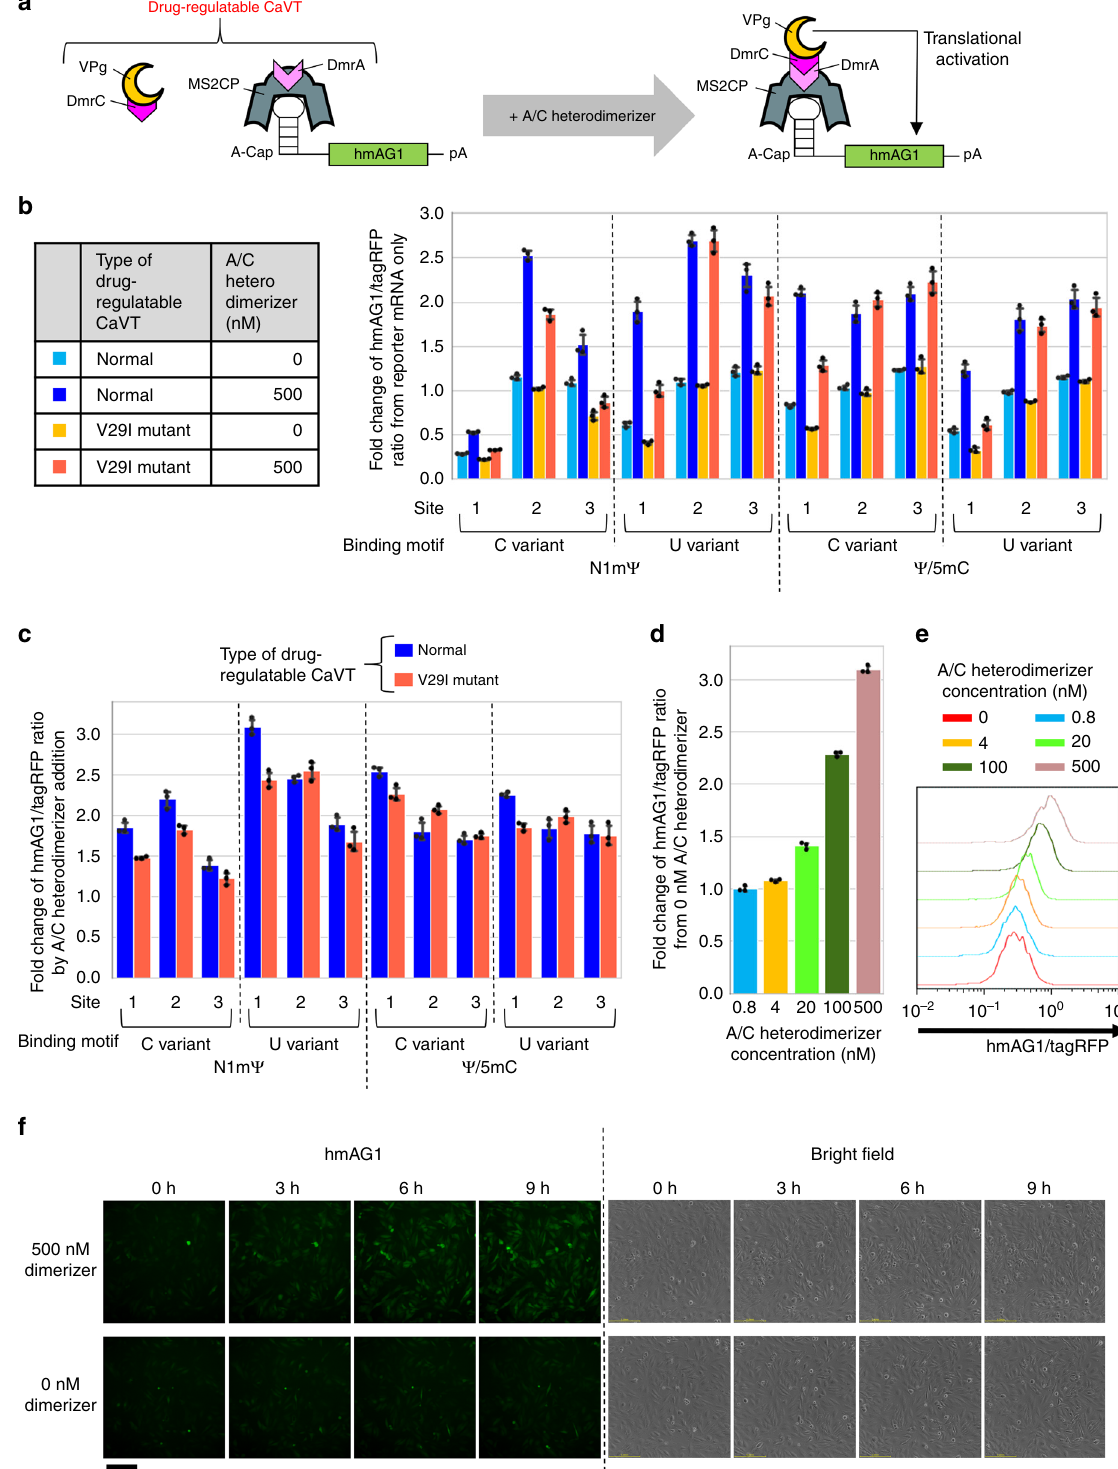
(Thermo Fisher Scienti fi c). One day after that, the cells were harvested using 200 μ L/ well of Trypsin/EDTA and suspended in 500 μ L/well of DMEM. Then, the fl uores- cence was measured by a BD Accuri C6 with CFlow Plus software (BD Biosciences, San Jose, USA). The excitation wavelength was 488nm for both tagRFP and hmAG1. Bandpass fi lters were 585/40nm for tagRFP and 530/30nm (90% attenuation) for hmAG1. Visualization of the data and calculation of the means of the hmAG1/tagRFP ratio in each cell expressing both hmAG1 and tagRFP were performed by FlowJo 7.6.5 (BD Biosciences). Microsoft Excel for Of fi ce 365 and Jupyter Notebook were used to depict bar graphs. The values of the fl uorescence compensation (0.7 – 0.9% for